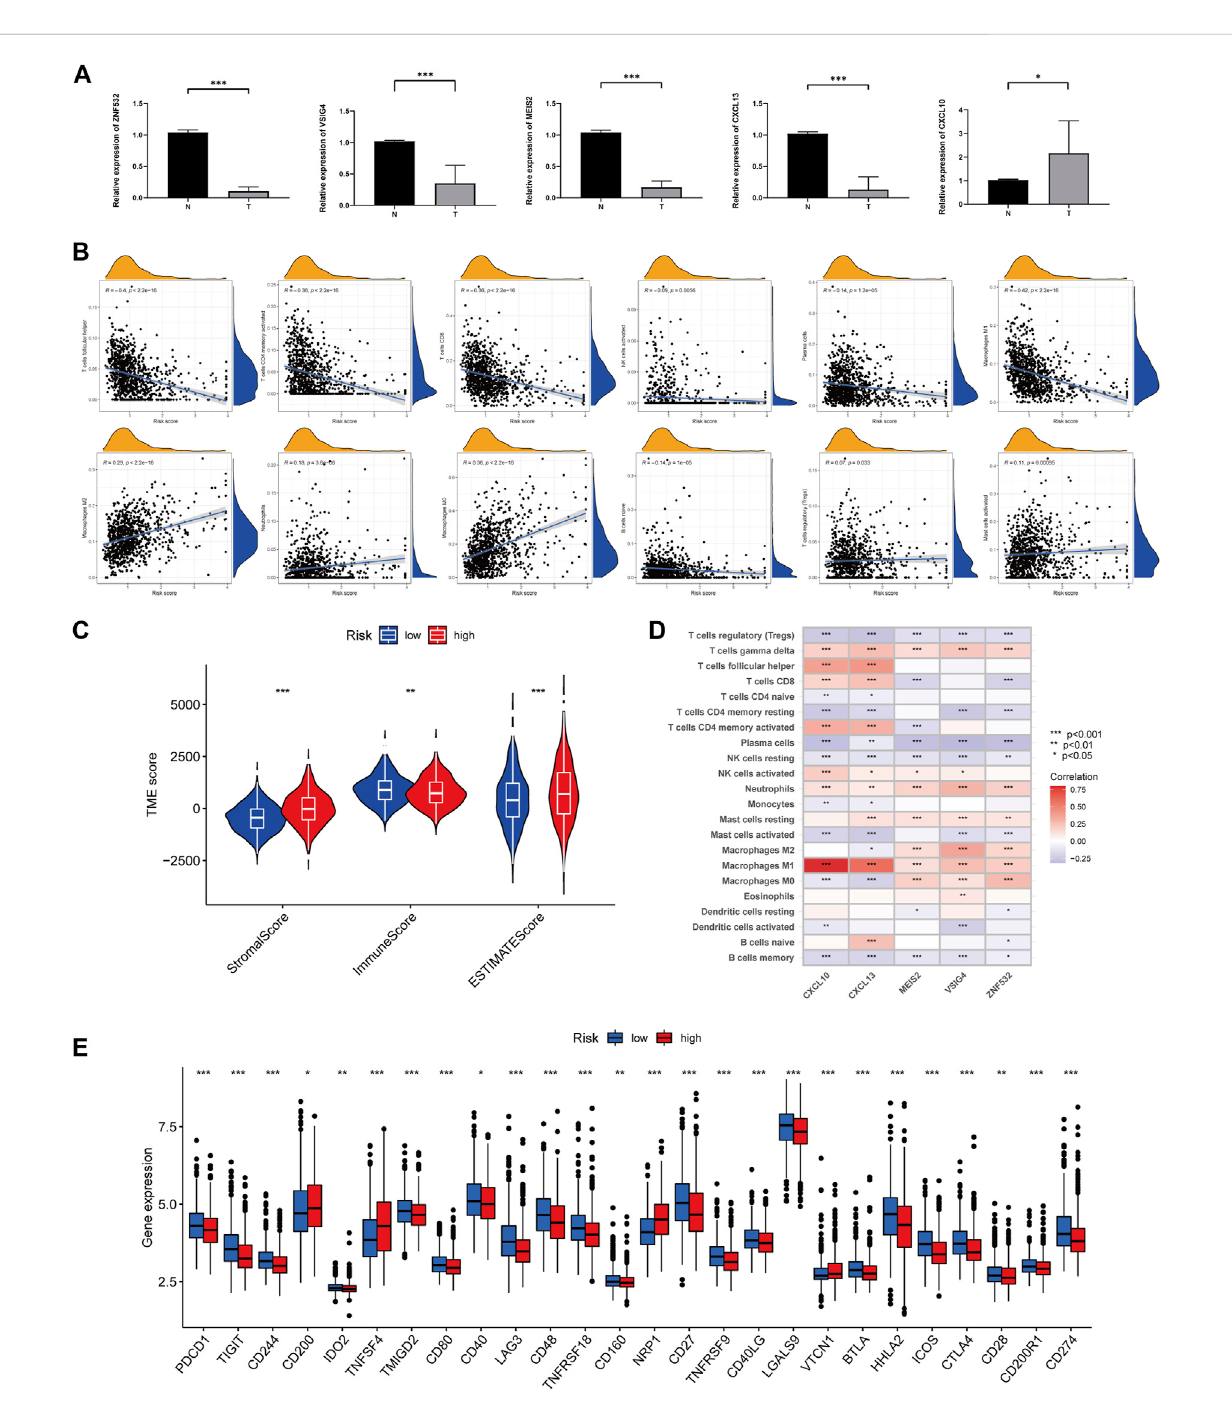
FIGURE 6 Comparison of TME and immune checkpoints between two subgroups. (A) Expression levels of fi ve angiogenesis-related genes of prognostic signature in colorectal cancer tissues and corresponding normal tissues by RT-qPCR. The asterisks represented the statistical p -value (* p < 0.05; *** p < 0.0001). (B) Correlation between immune cell type and ARGscore. The asterisks represented the statistical p -value (* p < 0.05; ** p < 0.01; *** p < 0.001). (C) Correlation between ARGscore and immune and stromal score. The asterisks represented the statistical p -value (* p < 0.05; ** p < 0.01; *** p < 0.001). (D) Correlation between the abundance of immune cells and fi ve genes in the prognostic model. (E) Differences in expression of immune checkpoints in high and low-risk groups. The asterisks represented the statistical p -value (* p < 0.05; ** p < 0.01; *** p <